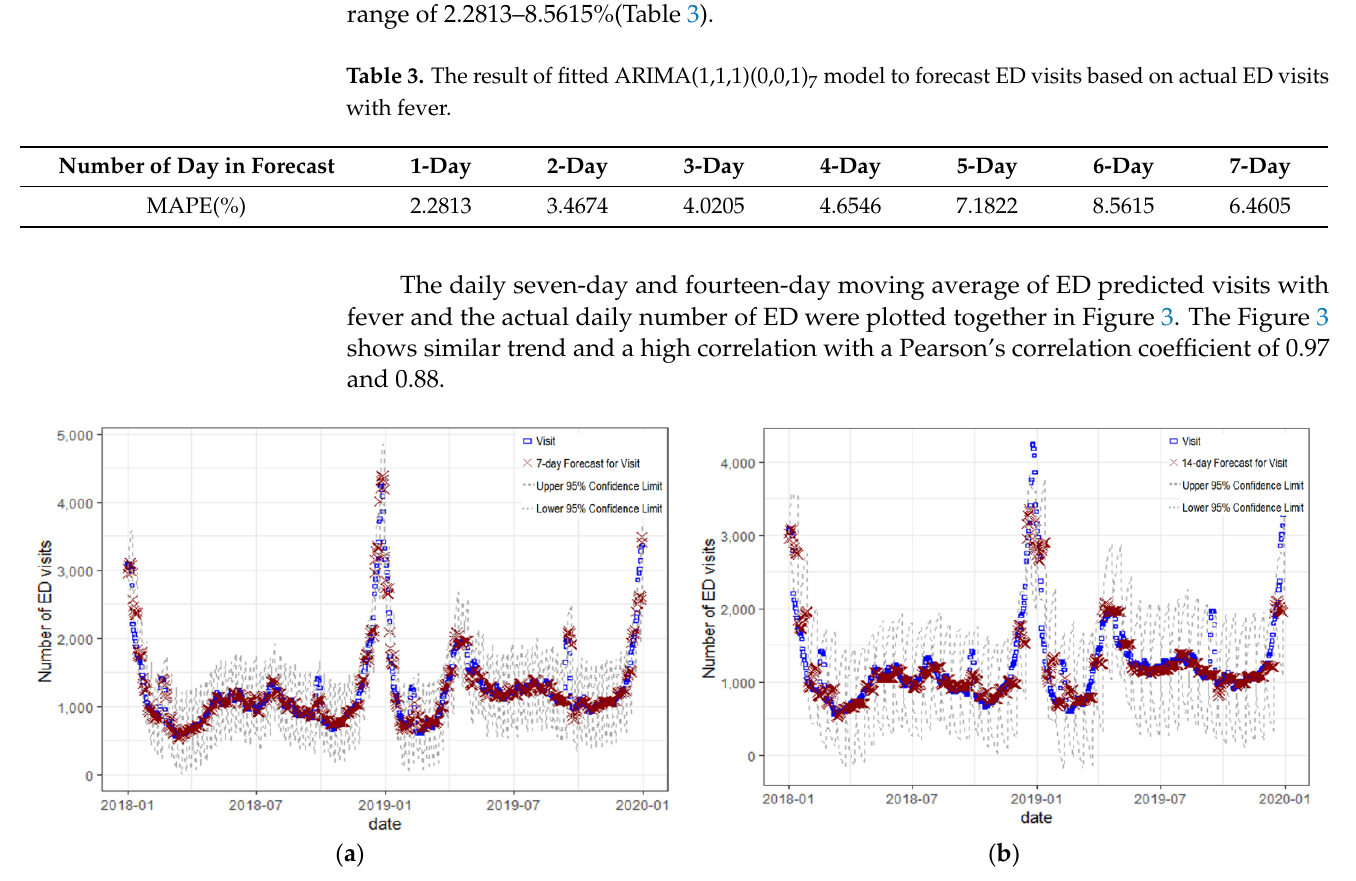
Table 2. Parameter estimation of the seasonal ARIMA(1,1,1)(0,0,1) ₇ model to forecast hospital visits due to influenza based on a seven ‐ day average ED visits with fever.